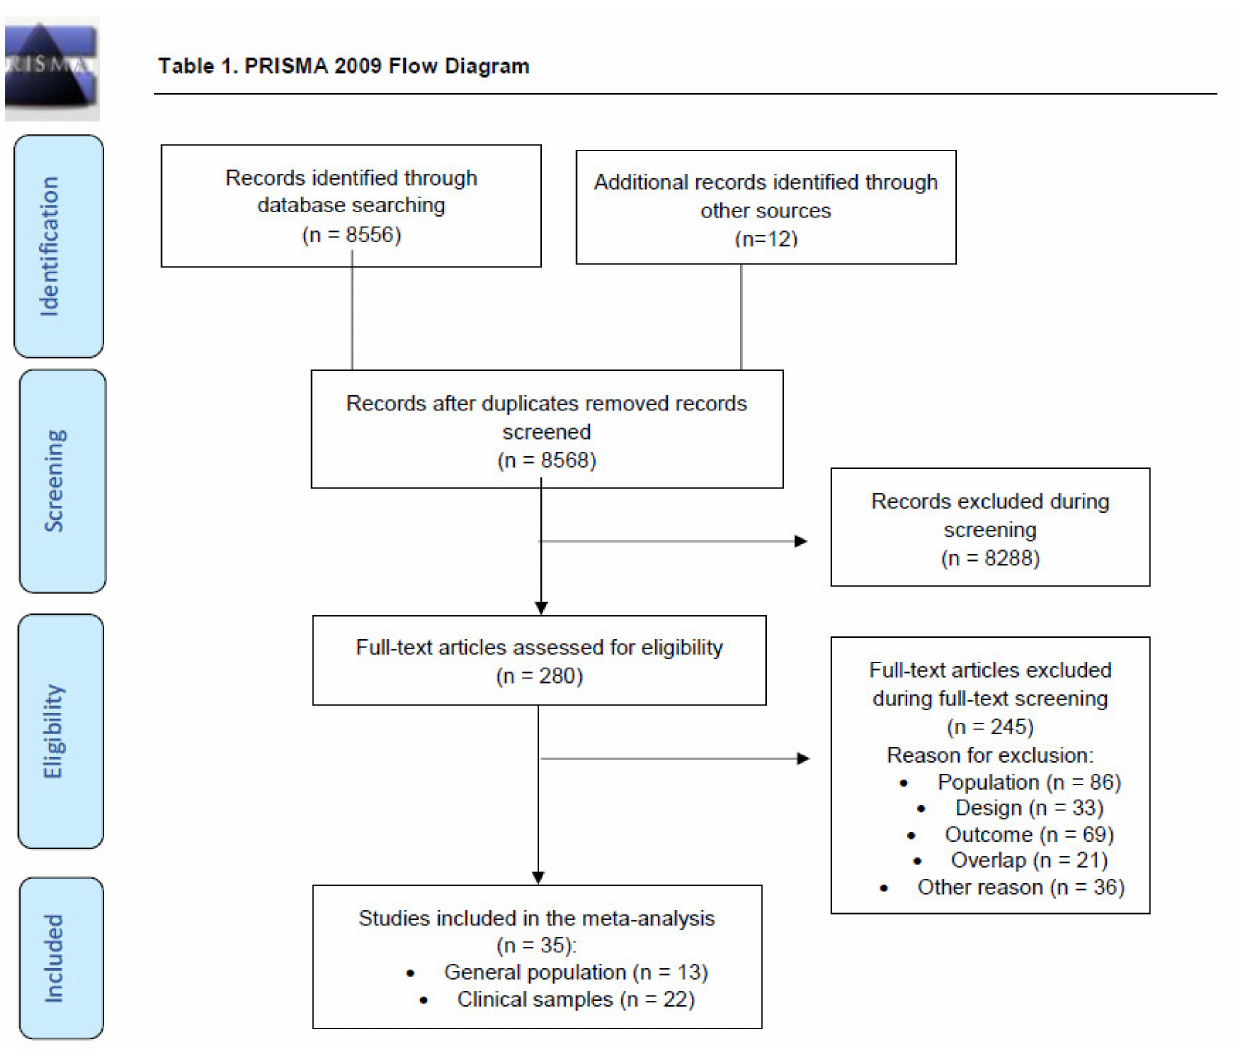
Figure 1. PRISMA 2009 Flow